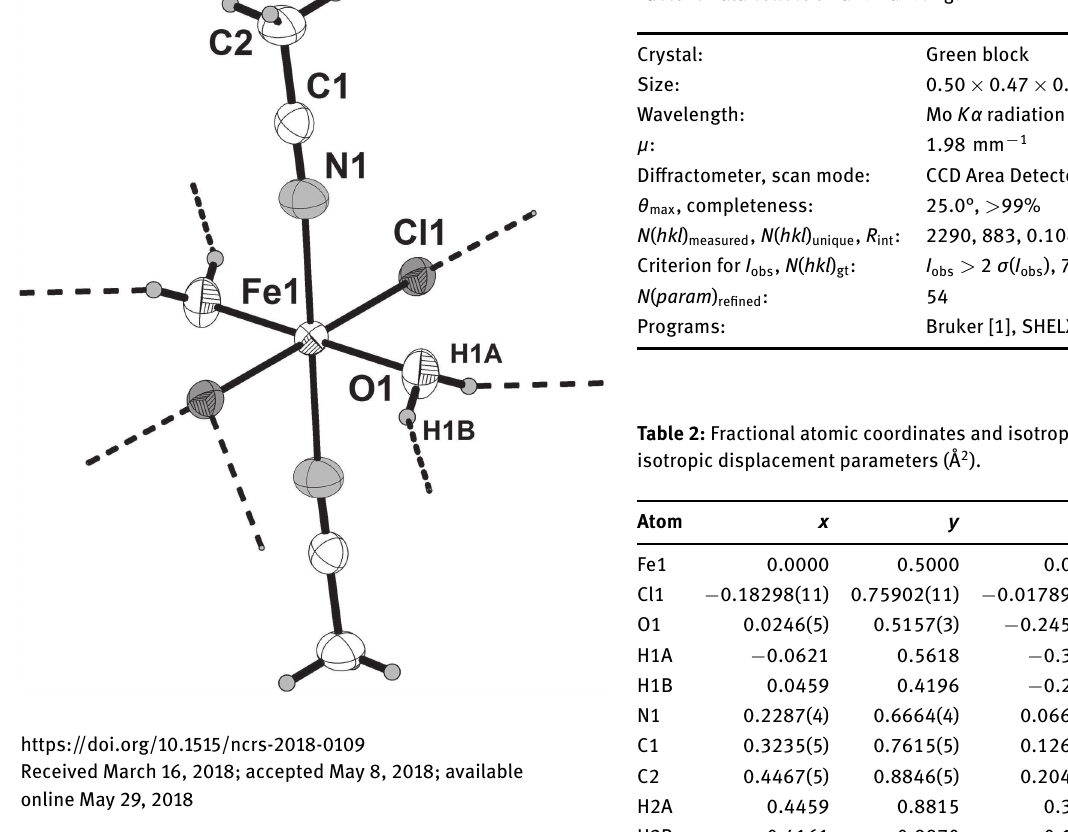
Table 1: Data collection and handling.